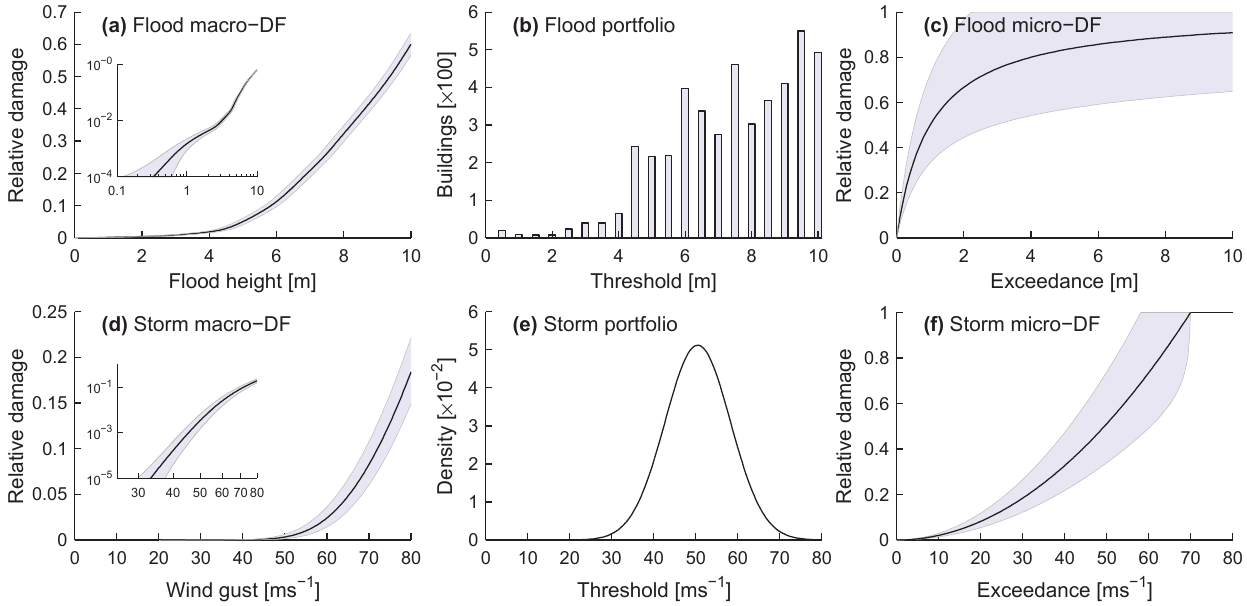
Figure 5. (a–c) show the damage function components for the case study of coastal flooding in Lisbon, Portugal. (d–f) demonstrate the methodology for storm damage within a building portfolio of 5000 individual buildings, based on the study by Heneka and Ruck (2008). The shaded areas around the damage functions indicate 95% confidence intervals. The insets in (a) and (d) show the macroscale damage function on a log–log